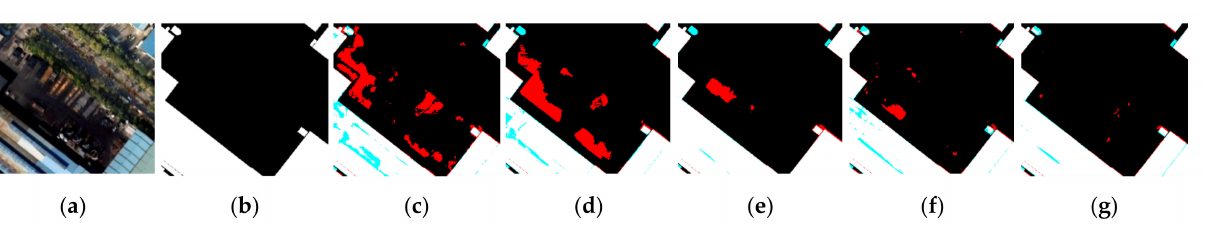
Figure 10. Building extraction results for test dataset 2 (industrial area) according to each deep learning model. The red and cyan regions indicate false positives and false negatives, respectively. ( a ) Original image. ( b ) Ground-truth labels. ( c ) Results of SegNet. ( d ) Results of U-Net. ( e ) Results of FC-DenseNet. ( f ) Results of HRNet-v2. ( g ) Results of csAG-HRNet.